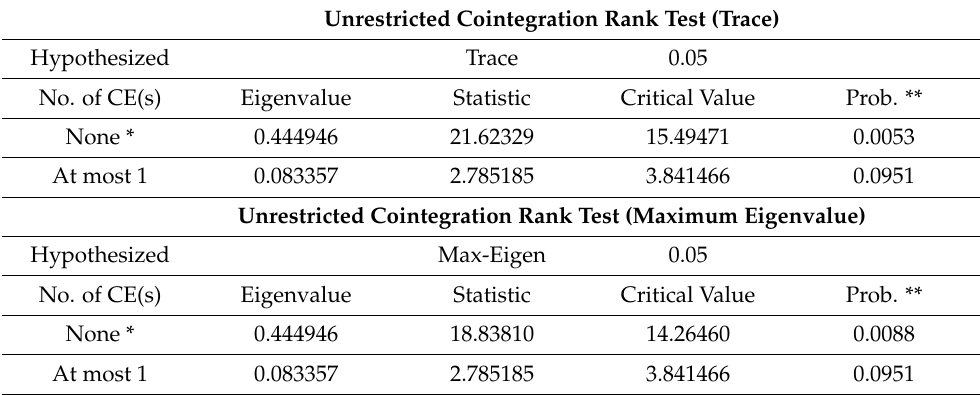
Table 5. The Johansen test on co-integration between health expenditure and economic